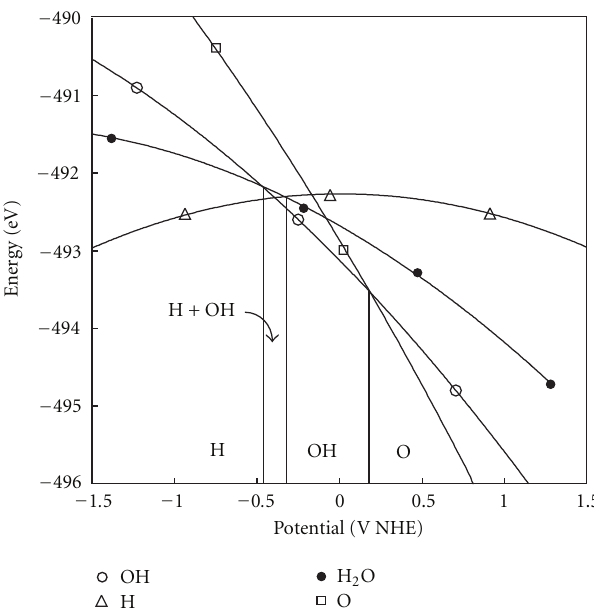
Figure 3: Phase diagram for surface hydride, molecular water, hydroxy and oxy species on Ni(111) at pH 0. Reproduced with permission from [30].